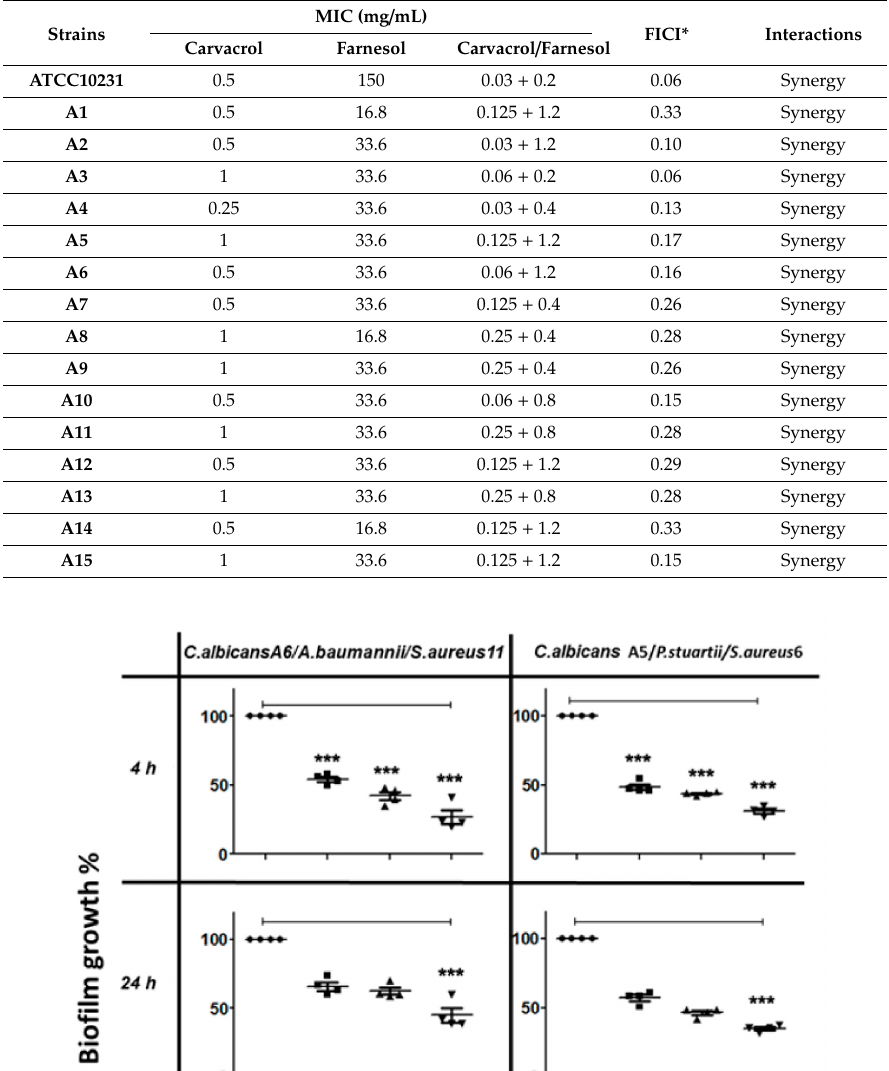
Table 2. Interactions (indicated by FIC indices) of carvacrol in combination with farnesol against C. albicans after 48 h of incubation.